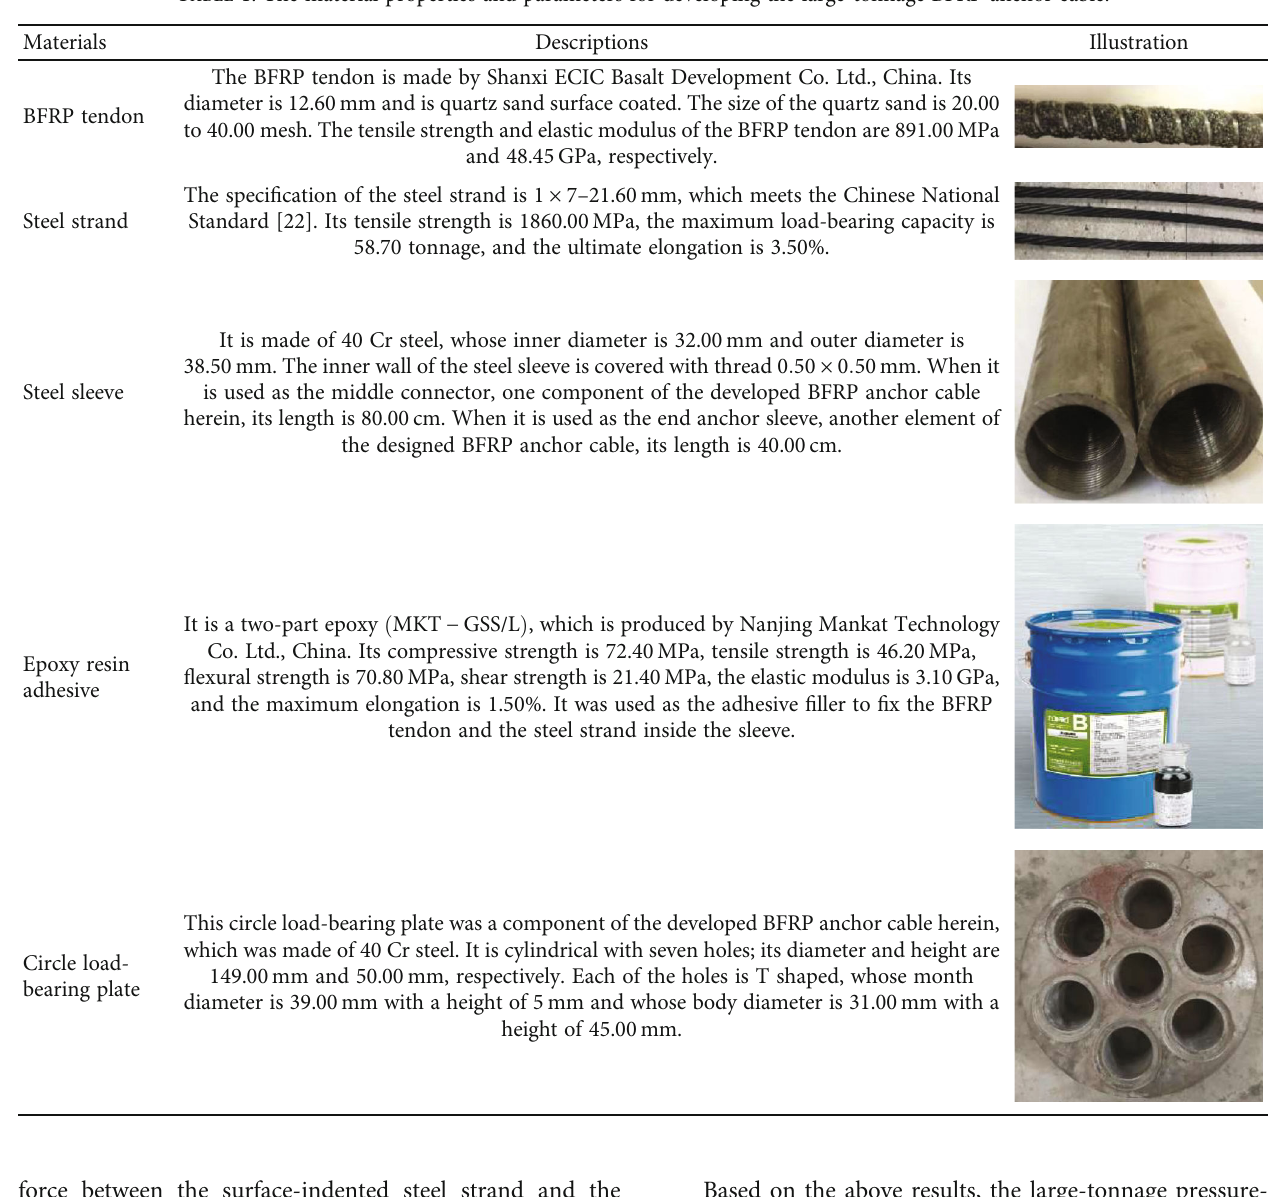
Table 1: The material properties and parameters for developing the large-tonnage BFRP anchor